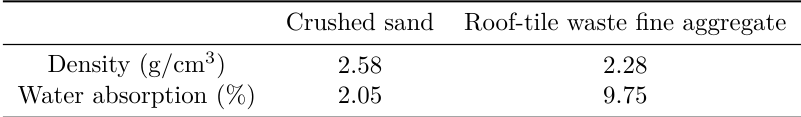
Table 2. Density and water absorption of crushed sand and roof-tile waste fine aggregate.